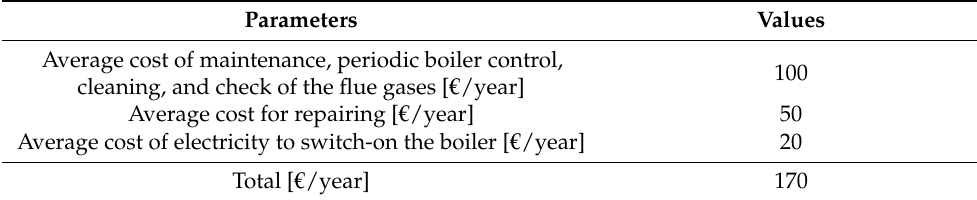
Table 4. List of yearly average costs for a residential/industrial